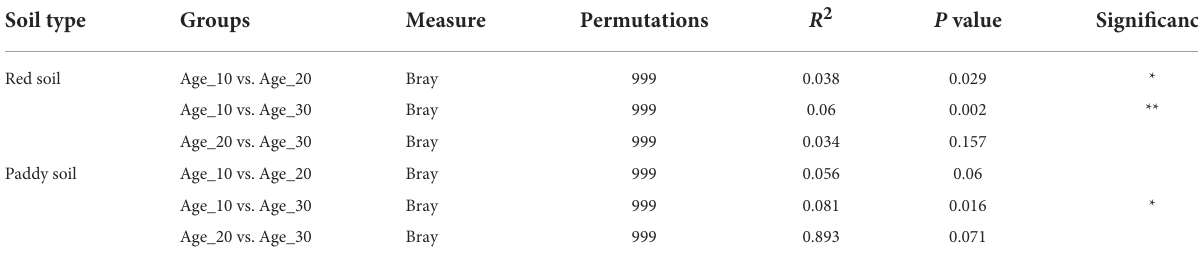
TABLE 1 Significance test of differences among fungal communities in different treatments using permutational analysis of variance based on Bray–Curtis distance.